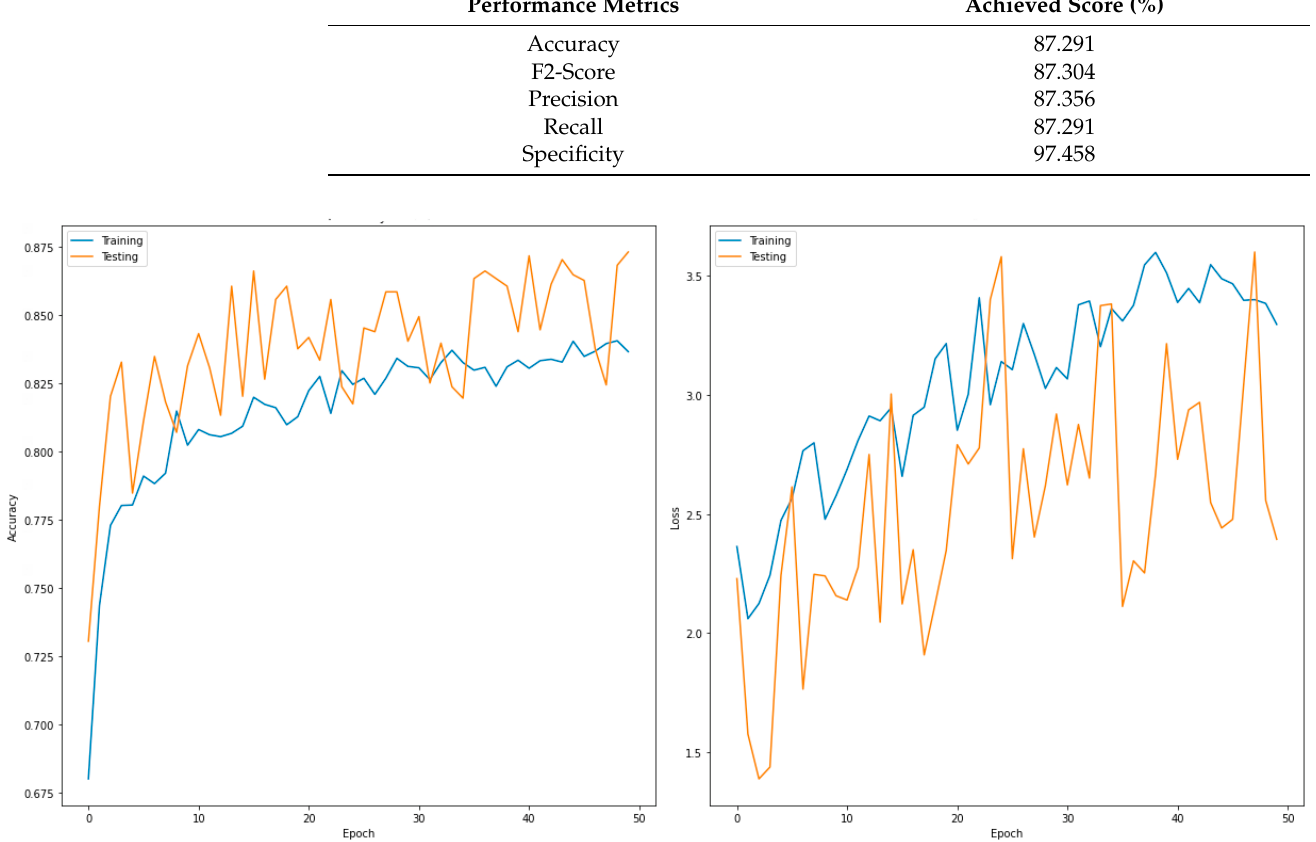
Figure 7. Accuracy ( left ) and loss curves ( right ) of DenseNet201 for six-class classifier. Table 14 lists the classification performances of the proposed model in terms of the accuracy for the two-class, three-class, four-class, five-class, and six-class classifiers. For the two-class classifier, the accuracy of DenseNet169 and VGG19 was 99.83%, which is the same as that of the other models in the two-class classifier. For the three-class classifier, the accuracy of DenseNet201 was the highest among all models, and, for the four-class classifier, the accuracy of VGG19 was the highest. Similarly, for the five- and six-class classifiers, the accuracies of DenseNet201 were 94.66% and 87.29%, respectively, which are the highest among the models. Interestingly, for the two-class, three-class, and four-class classifiers, the accuracies were 99.83, 98.11%, and 97%, respectively. Similarly, for the five-class and six-class classifiers, the accuracies were 96.66% and 87.29%, respectively. The accuracy gradually decreased as the number of classes increased. Table 14. Accuracy (%) of the proposed model for different classes using different deep learning networks.